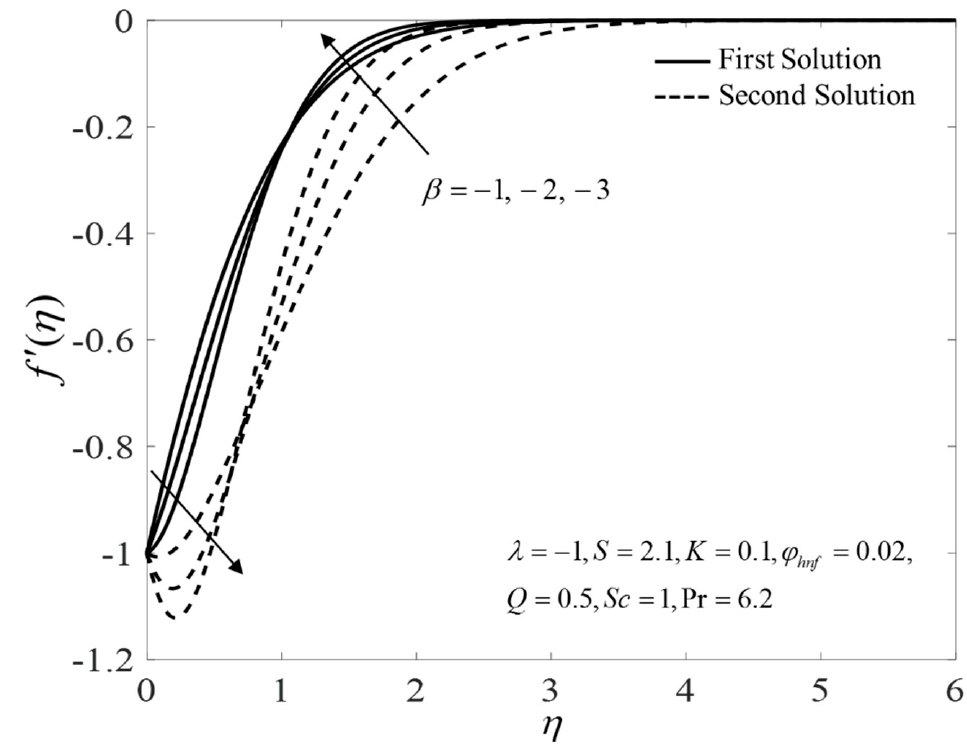
Figure 5. Plot of f (cid:48) ( η ) for several values of β Figure 5. Plot of ( ) f  for several values of  .